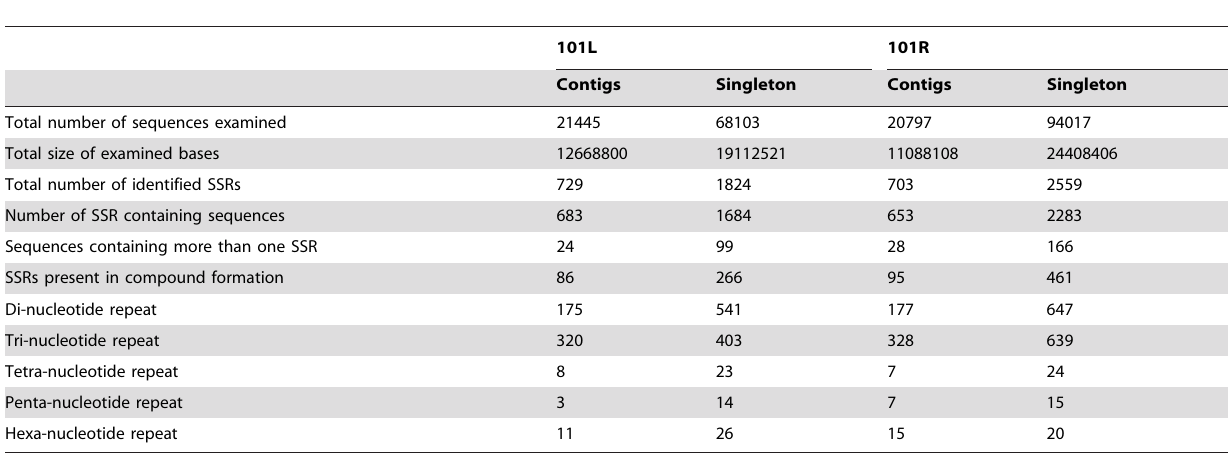
Table 6. Statistics of SSRs identified from leaf and root transcriptome